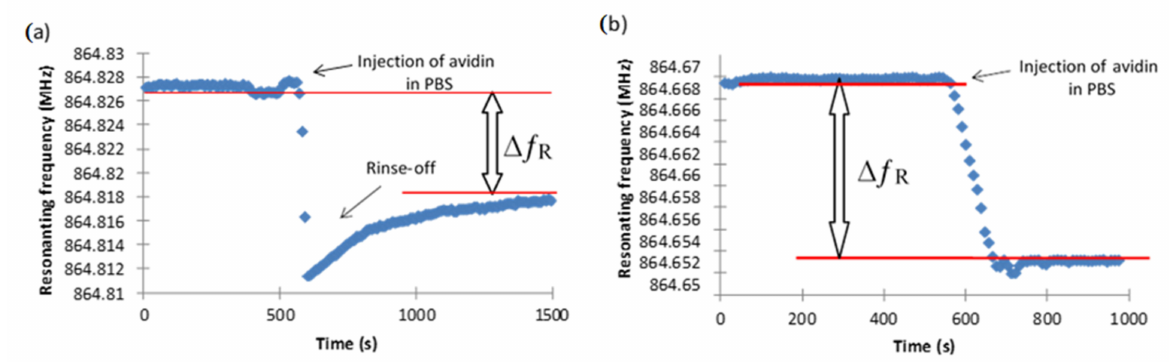
Figure 7. EMPAS response profiles for ( a ) OEG–TUBTS SAM and ( b ) biotinylated OEG–TUBTS SAM using a 0.1 mg mL − 1 avidin